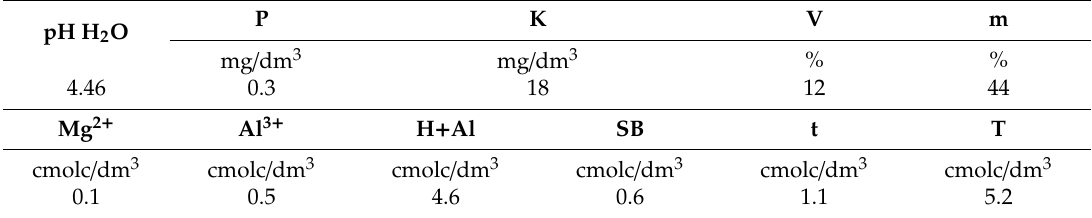
Table 3. Soil chemical analysis of the experiment, performed in April